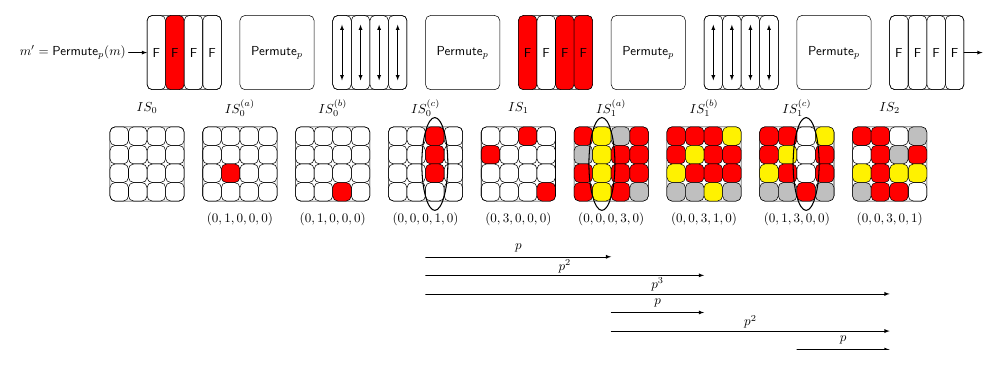
Figure 6: A differential trail of the form (1 → 3 → 1) or (1 → 3 → 2) in SE K , 3 , where Permute p is instantiated by the original cell permutation of Midori